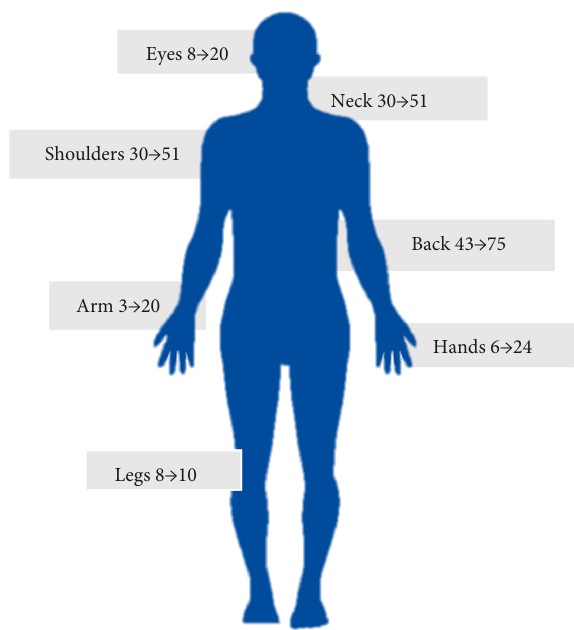
Figure 1: The prevalence of pain in various regions as experienced by dental students before and after participating in dental clinical